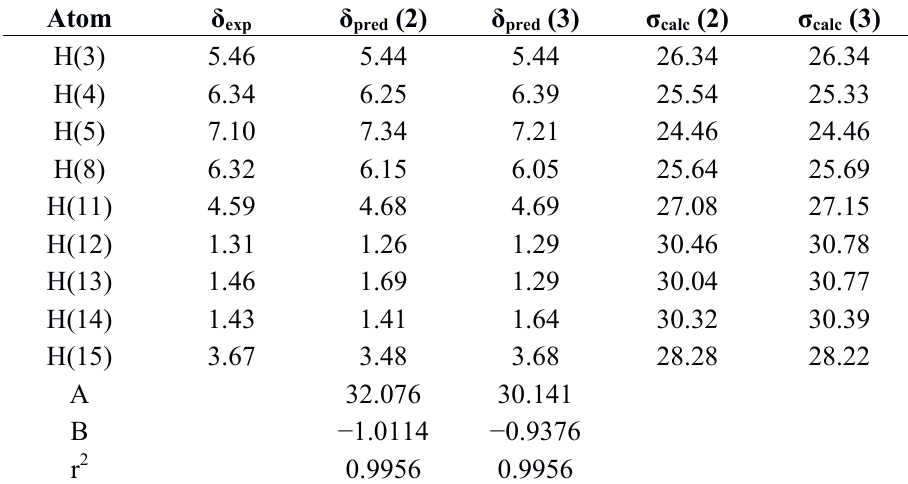
Table 5. Experimental chemical shifts ( δ ) from the GIAO/B3LYP/6-311++G(d,p) calculations for encecanescin ( 1 ); tensors ( σ calc δ = a+b· σ : ( a ) 13 C (a = 173.81; b = − 0.946; r 2 = 0.9986) and ( b ) 1 H (a = 32.101; exp calc b = − 1.0124; r 2 =